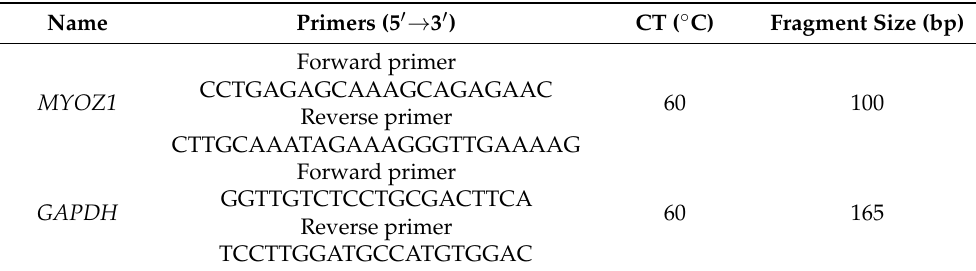
Table 1. qRT-PCR primers for duck MYOZ1 and GAPDH.